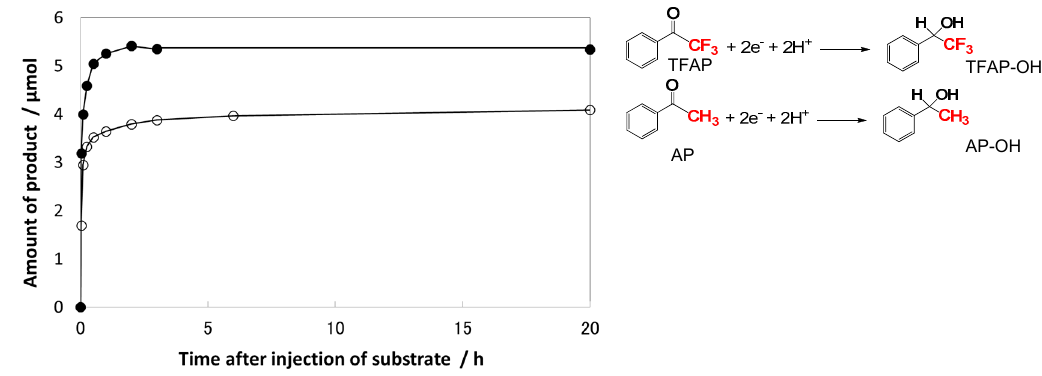
Figure 4. Time evolutions of the amount of AP-OH ( ○ ) and TFAP-OH ( ● ) after the 300 μ mol injection of substrate (AP or TFAP) into the 2 h pre-irradiated TiO 2 suspension at 32 °C Adapted with permission from reference [63]. Copyright (2012) American Chemical Society.